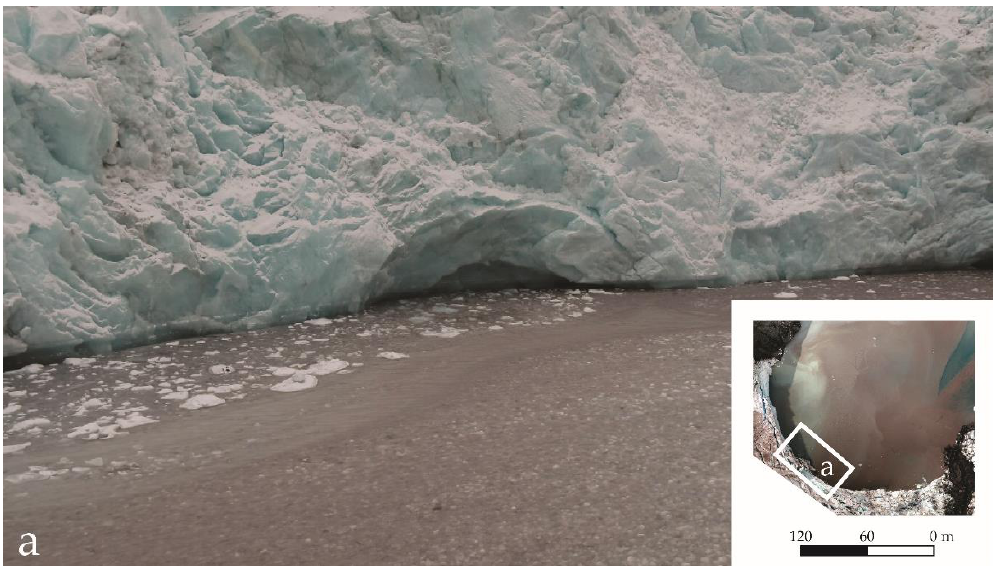
Figure 1. Photograph of a meltwater conduit at the margin of Zalewski Glacier.